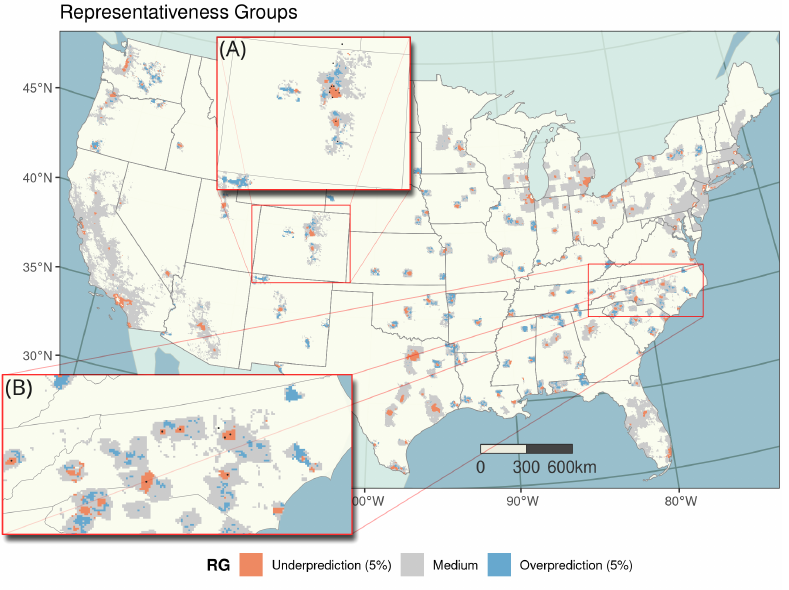
Figure 6. All identified subregions accumulated over the entire study period. The states of Colorado ( A ) and North Carolina ( B ) are highlighted to show the results in more